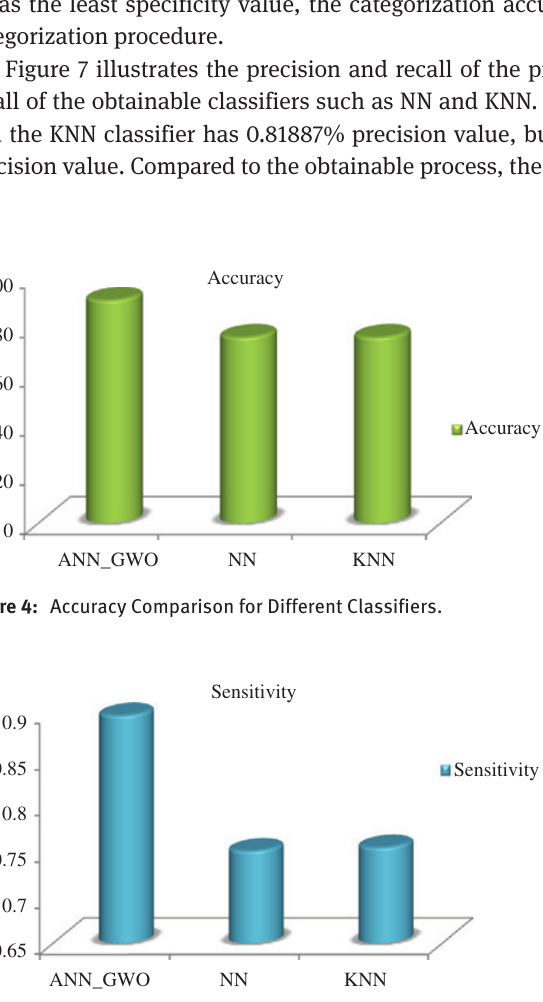
Figure 5: Sensitivity Comparison for Different Classifiers.